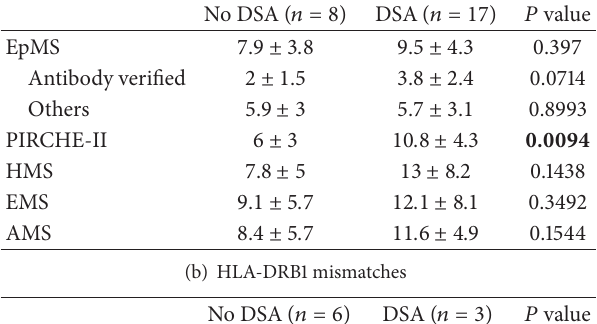
Table 3: Comparison of the different mismatch characteristics between mismatches that led to the formation of DSA and ones that did